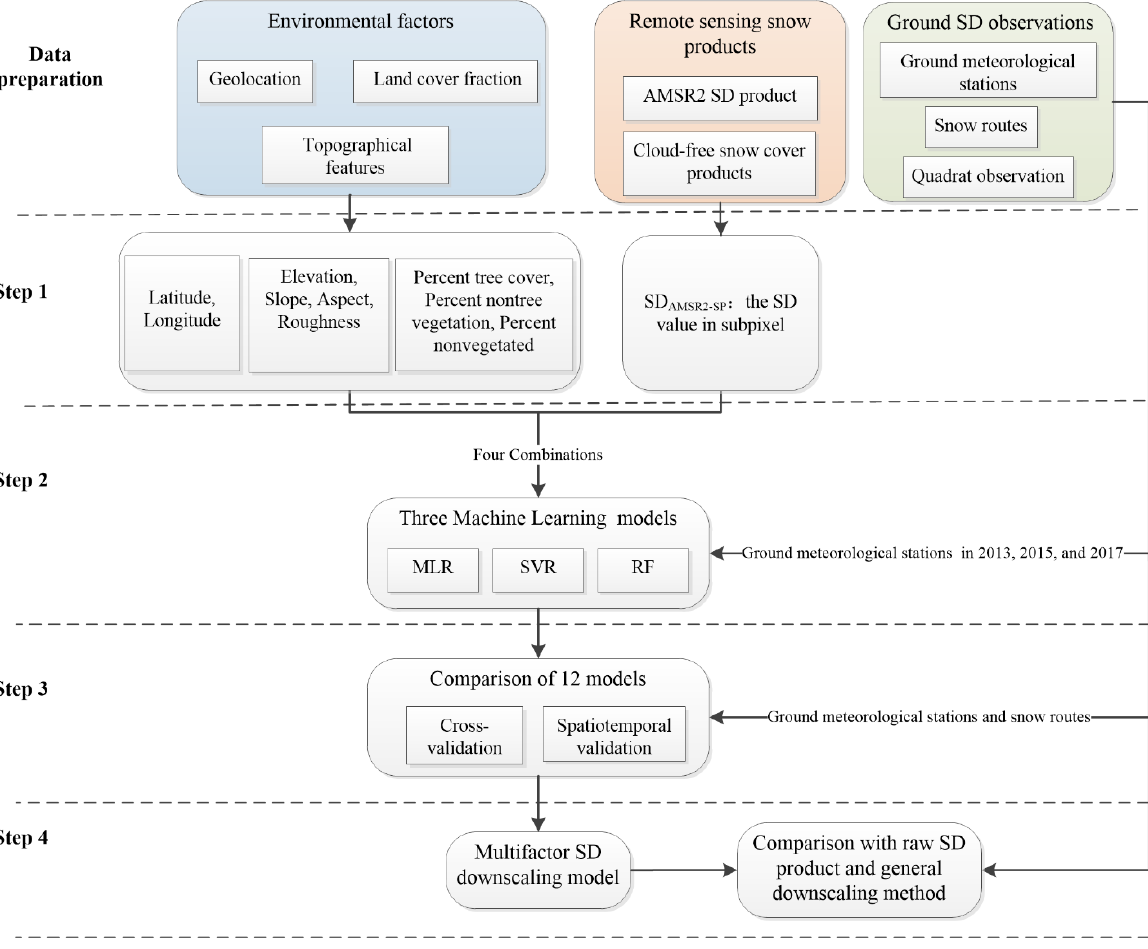
Figure 2. Flowchart of the multifactor SD downscaling model procedure.